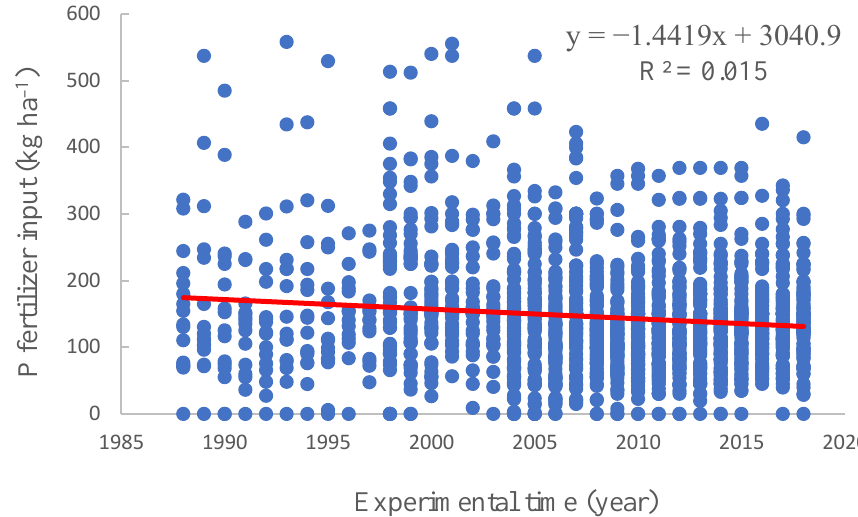
Figure A4. P fertilizer amount over time in 91 experiment sites.